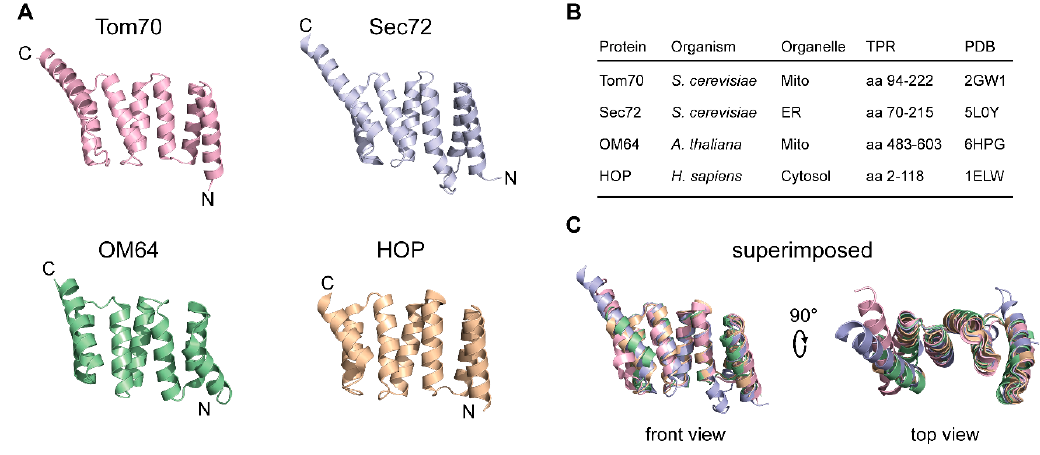
Figure 4. Comparison of clamp-type TPR domains of S. cerevisiae Tom70 and functional analogs in other membrane systems. ( A ): Sec72 mediates the recognition of Ssa1 at the ER membrane in yeast. OM64 mediates protein recognition and import across the outer chloroplast membrane in analogy